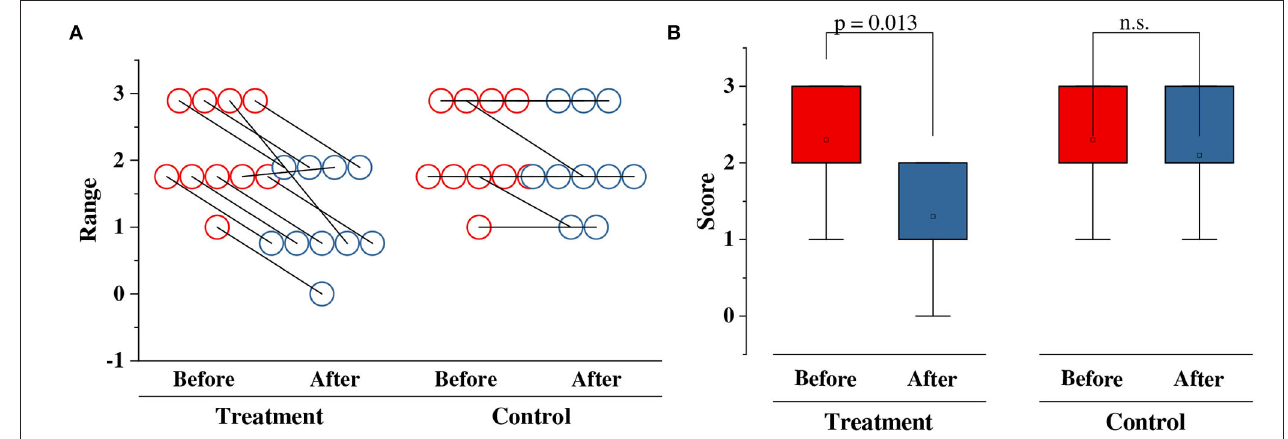
FIGURE 1 | Scores in two groups: (A) Raw statistics; (B) Comparison results. n.s, no